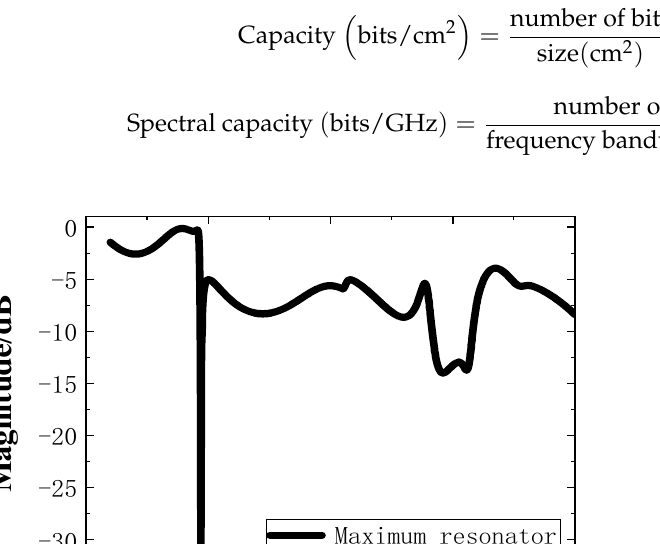
resonator corresponds to a resonant frequency of 4.7 GHz.